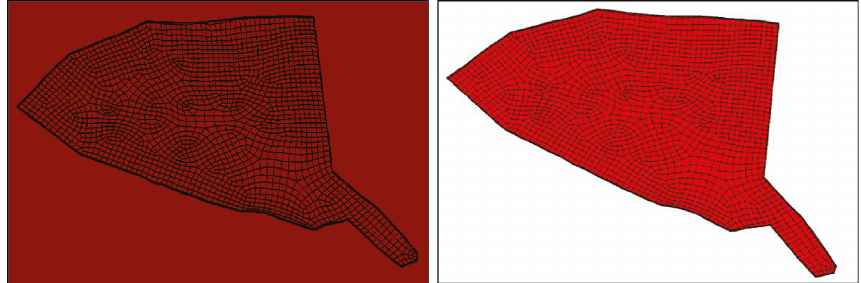
Figure 19: Plastic zone of Dasha landslide slip surface under the gravity.